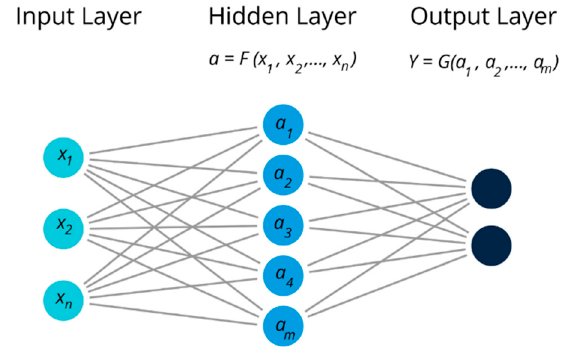
Figure 5. Schematic representation of the artificial neural network architecture.